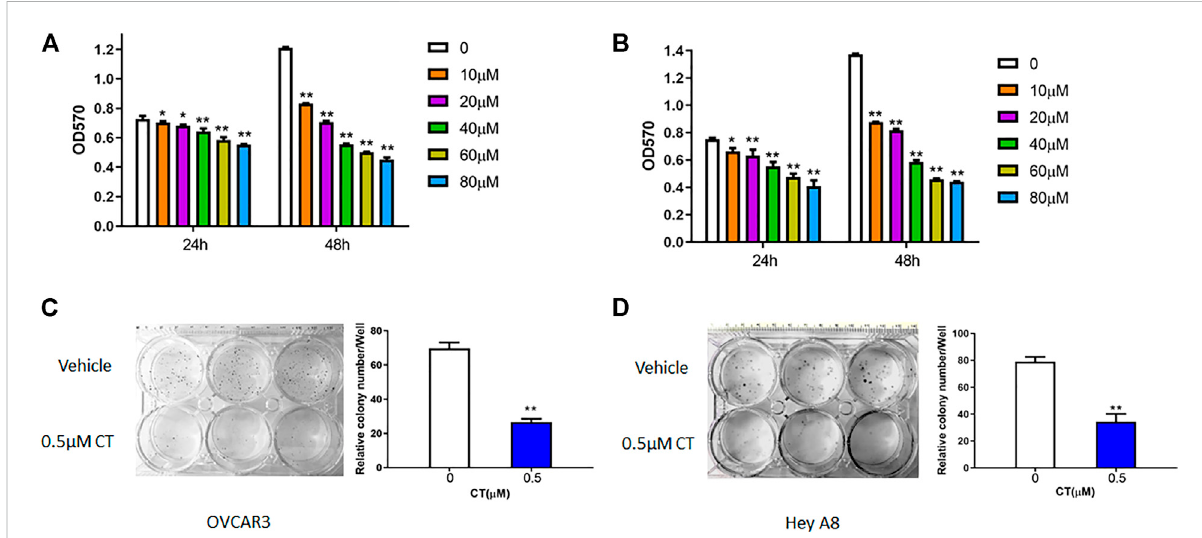
FIGURE 1 CT inhibits ovarian cancer cell proliferation. (A,B) MTT proliferation assay in OVCAR3 (A) and HEY A8 (B) cells treated with different doses of CT for 24 or 48 h. (C,D) Colony formation assay of OVCAR3 and HEY A8 cells treated with 0.5 μ M CT for 14 days. Representative images and average colony numbers are shown. Data were presented as mean values ±SD. * p < 0.05, ** p < 0.01, versus control group ( n =